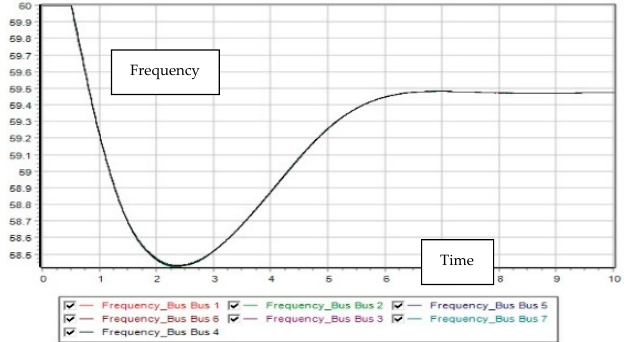
Figure 13. Fluctuation of bus frequency due to sudden increment of load at buses 5 and 7.